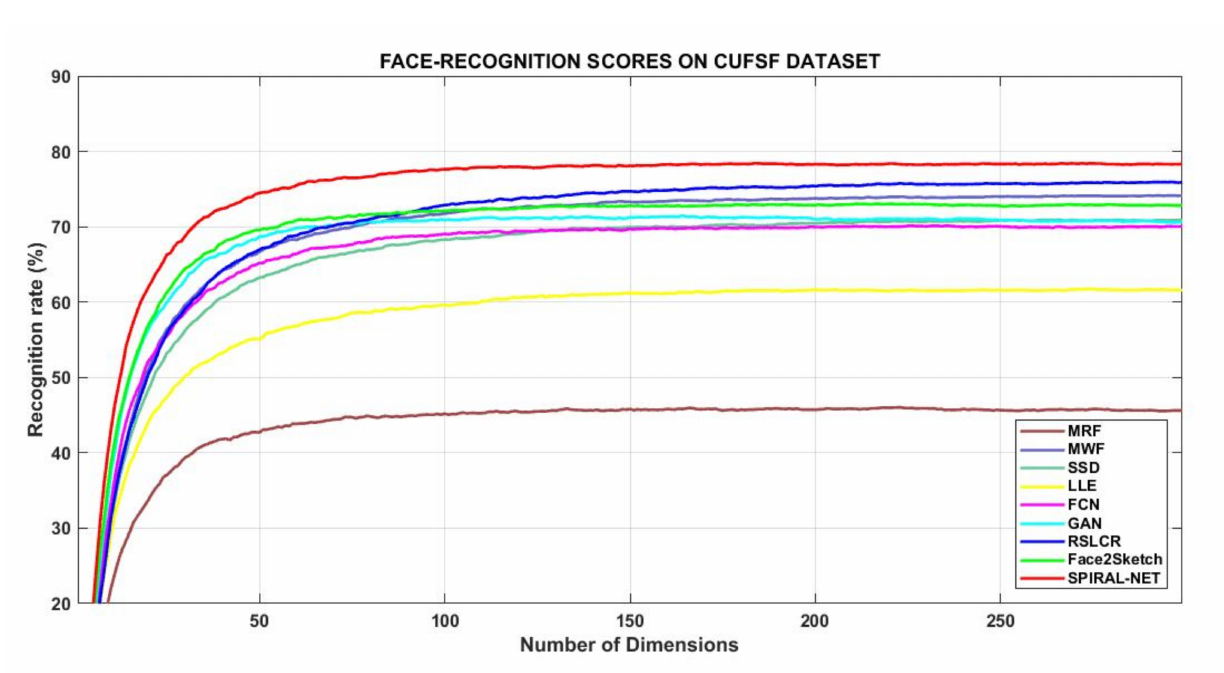
Figure 4. Comparative view of NLDA scores by different techniques on CUFSF